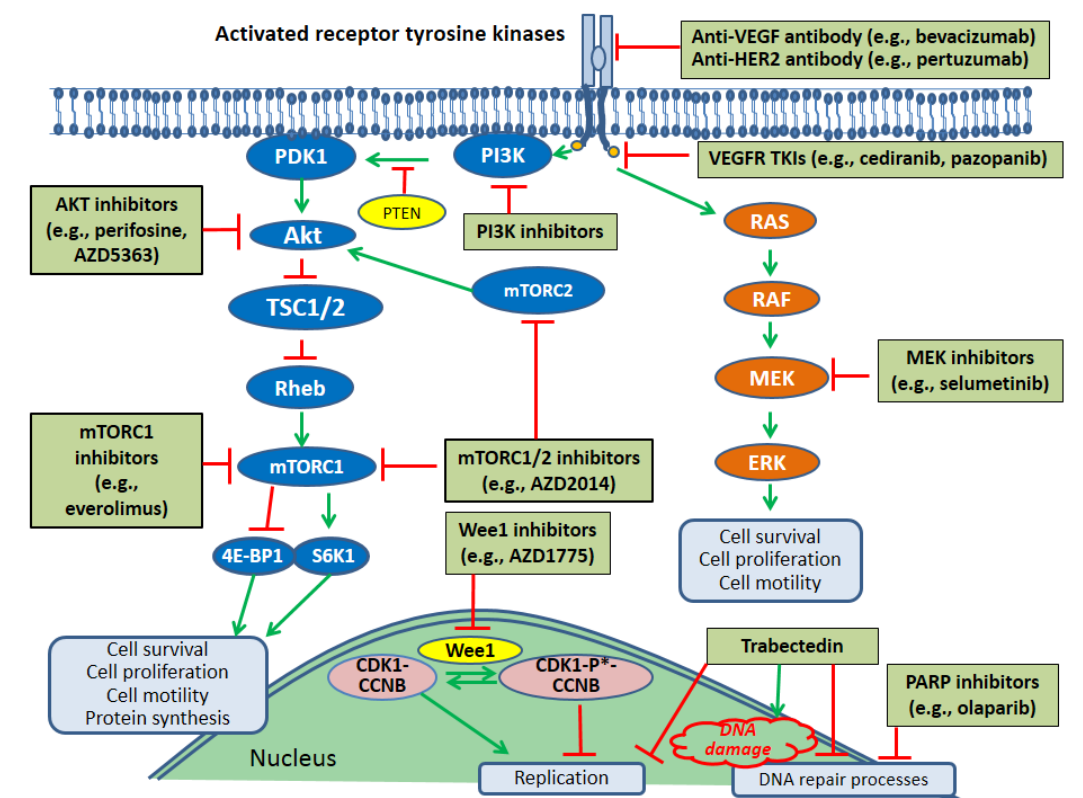
Figure 3. Molecular targets in ovarian cancer treatment; * Indicates inactive (phosphorylated) form of cyclin-dependent kinase 1; Green arrows indicate stimulation while the red lines indicate inhibition; 4E-BP1: eukaryotic translation initiation factor 4E-binding protein 1; AKT: protein kinase B; CCNB: cyclin B; CDK1: cyclin dependent kinase-1; ERK: extracellular signal-related kinase; HER2: human epidermal growth factor receptor 2; MEK: MAPK/ERK kinase; mTORC1: mammalian target of rapamycin complex 1; mTORC2: mammalian target of rapamycin complex 2; PDK1: phosphoinositide-dependent kinase-1; PI3K: phosphoinositol 3-kinase; RAF: a serine/threonine-specific kinase; RAS: a member of a specific GTPase superfamily; Rheb: Ras homolog enriched in brain protein; S6K1: S6 kinase beta-1; TSC1/2: tuberous sclerosis proteins 1 and 2; VEGF: vascular endothelial growth factor; VEGFR: vascular endothelial growth factor